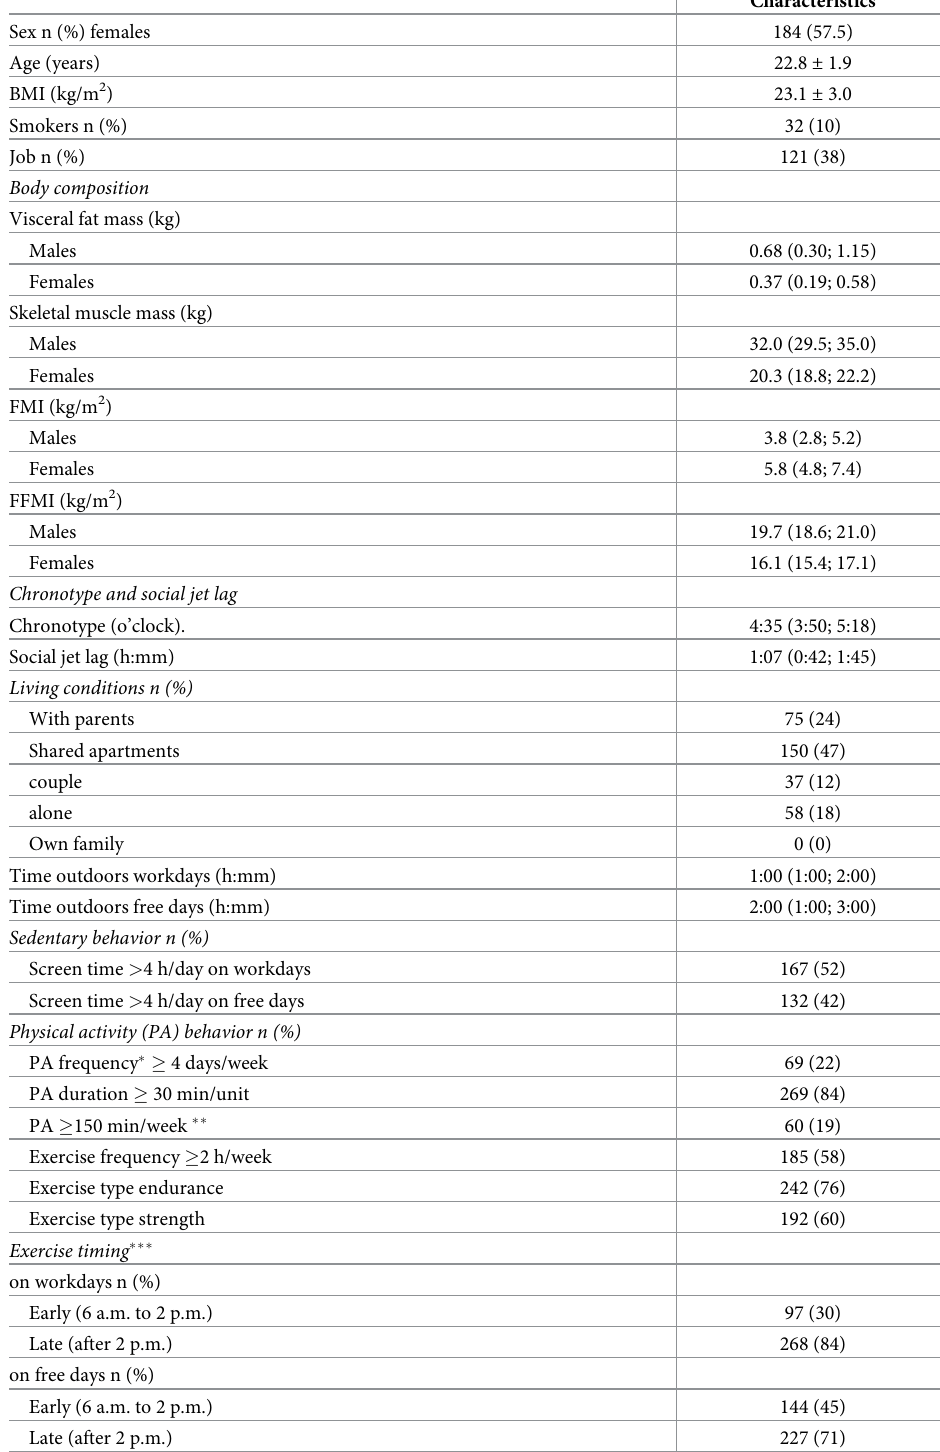
Table 1. Characteristics of German university students aged 18–25 years at baseline assessment of the ChroNu study (n = 320).